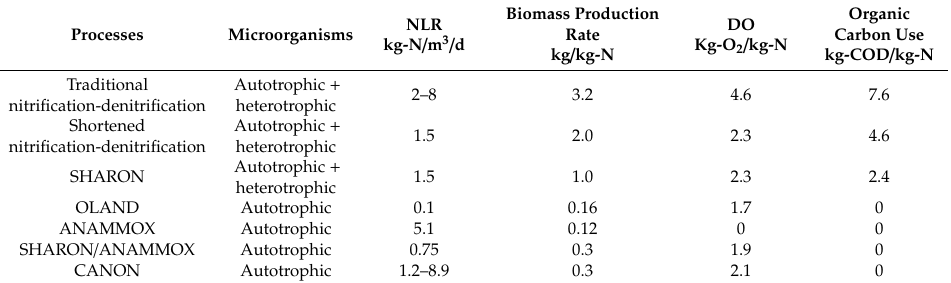
Table 1. Anammox or its combinations compared to traditional